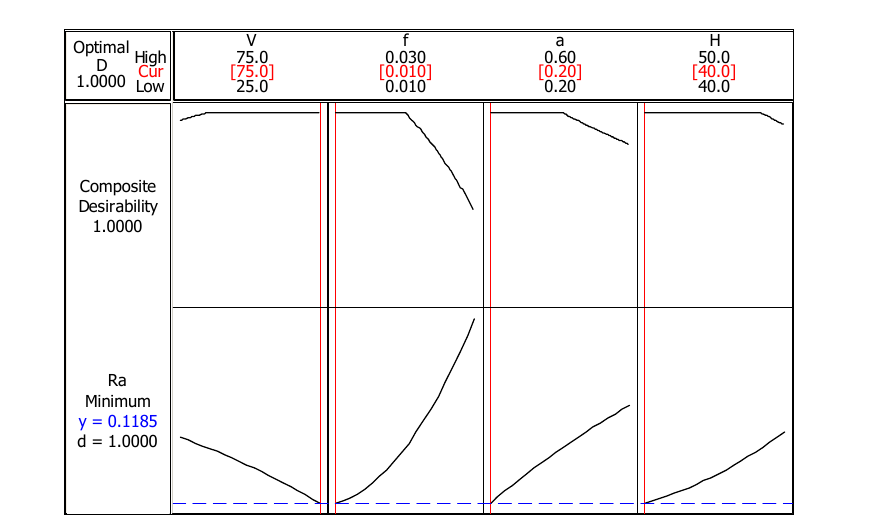
Figure 9. Single objective optimization plot.